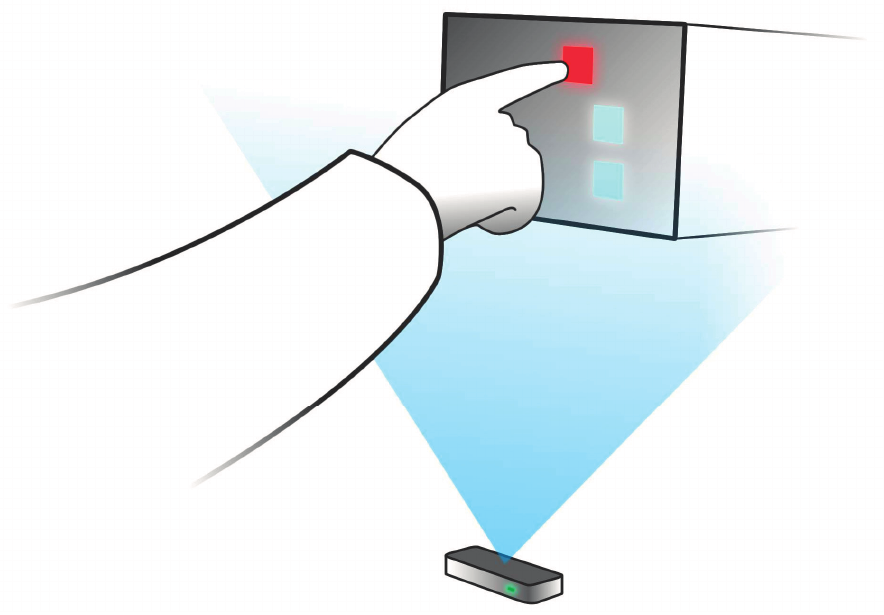
Figure 10. Interaction with the light field display using Leap Motion Controller as finger tracking